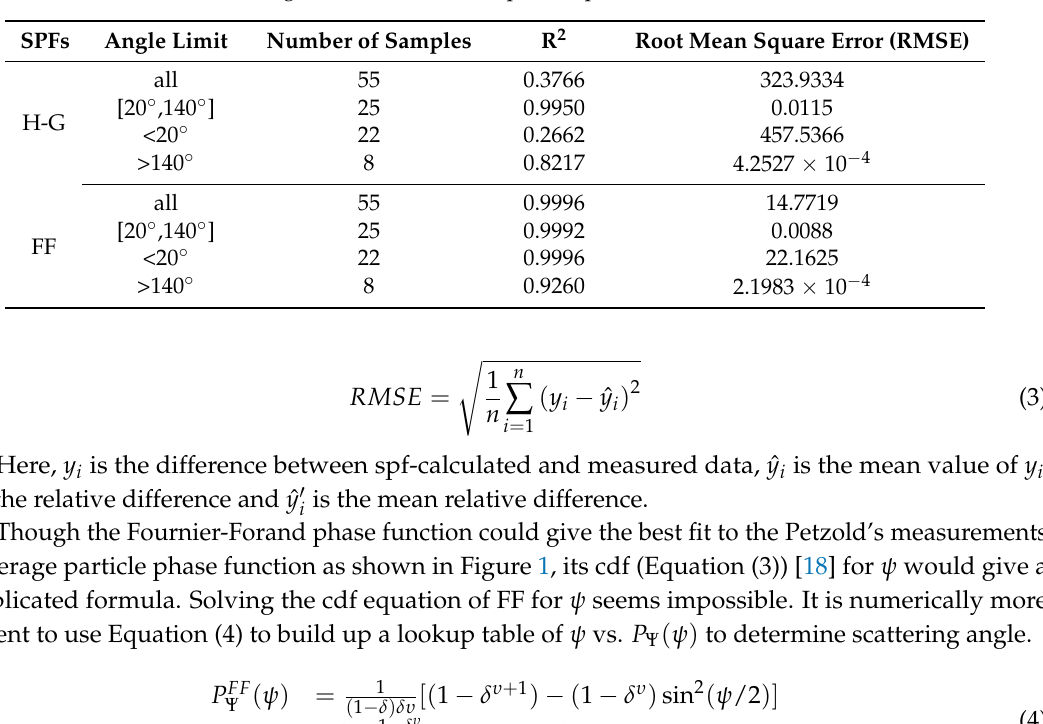
Table 1. The curve-fitting statistics of the two spfs compared with Petzold’s